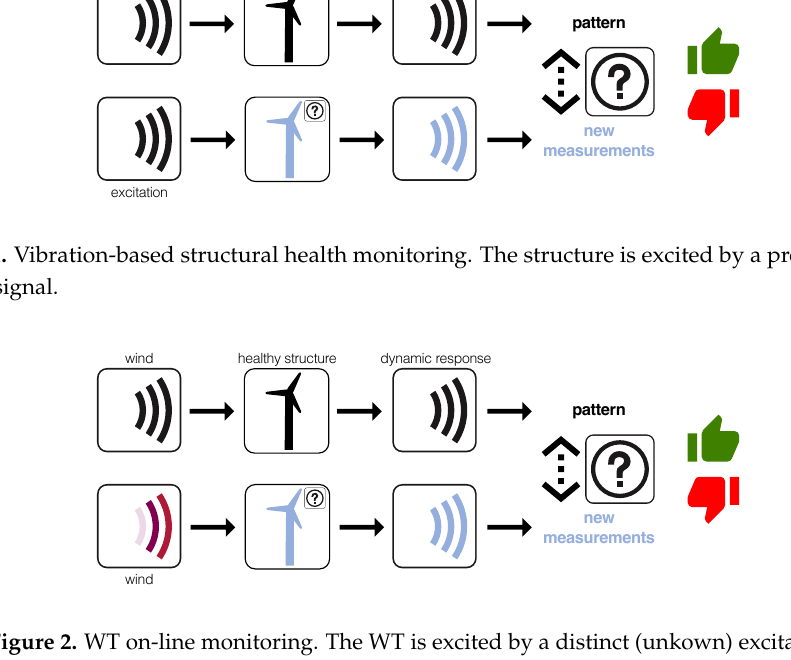
Figure 2. WT on-line monitoring. The WT is excited by a distinct (unkown)